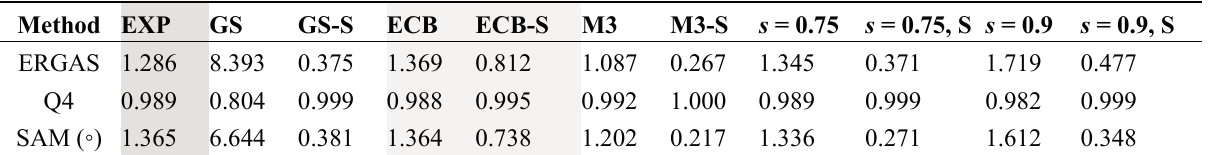
Table 13. Quantitative comparison of the fusion results after degrading the images into the LR resolution, i.e ., at 2.0 m, to check the consistency property of the Wald’s protocol for the WorldView-2 group 2 dataset at full